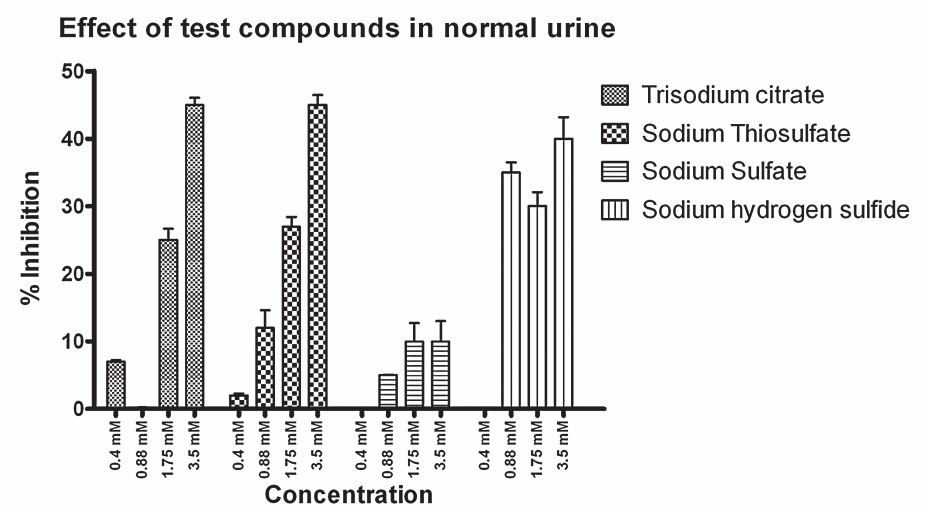
Figure 4 - Effect of test compounds on kinetics of calcium oxalate in normal urine. Data are mean±S.D. of three observations.